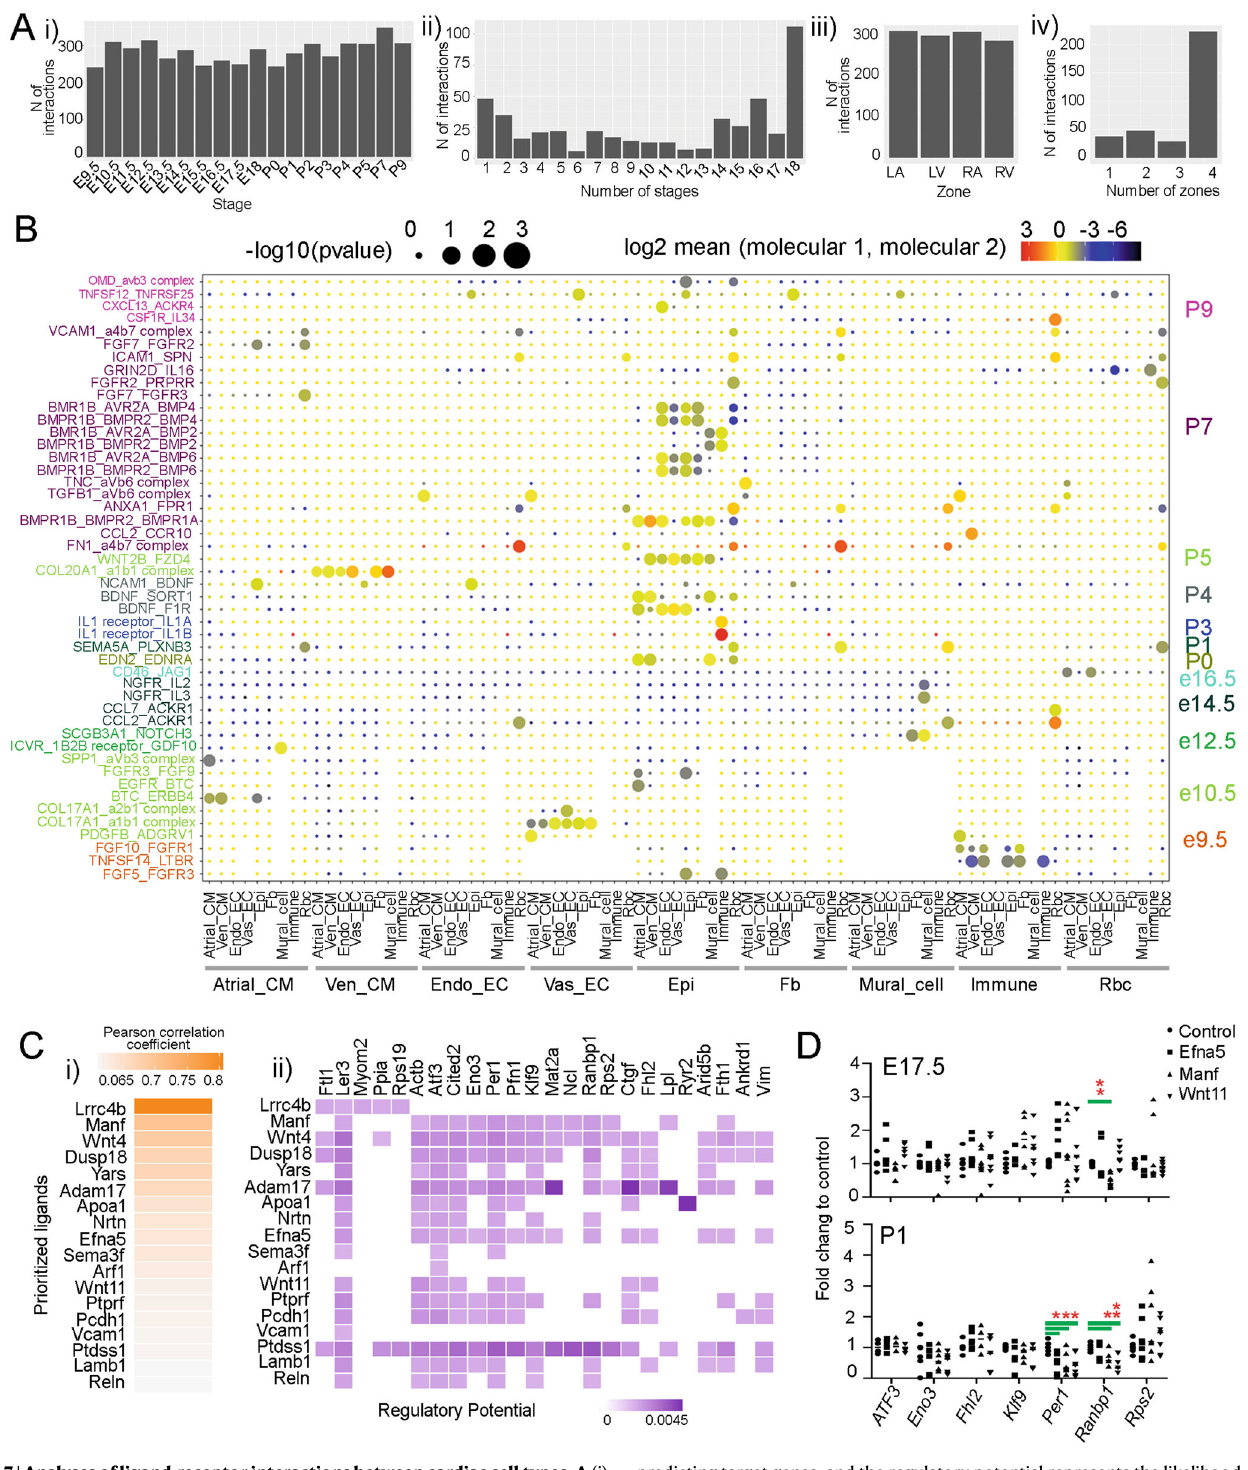
predicting targetgenes, and the regulatorypotential represents the likelihoodof a regulation between one ligand and one target gene. D Quanti fi cation of target genes ’ expressioninE17.5andnewbornmouseCMsaftergrowthfactortreatments. The relative expression of each target gene after treatment was normalized to GAPDH and control samples. ANOVA with Dunnett ’ s posthoc test was used for the statistical analysis between each treatment and the control. * and ** indicate sig- ni fi cance with p value<0.05 and 0.01,